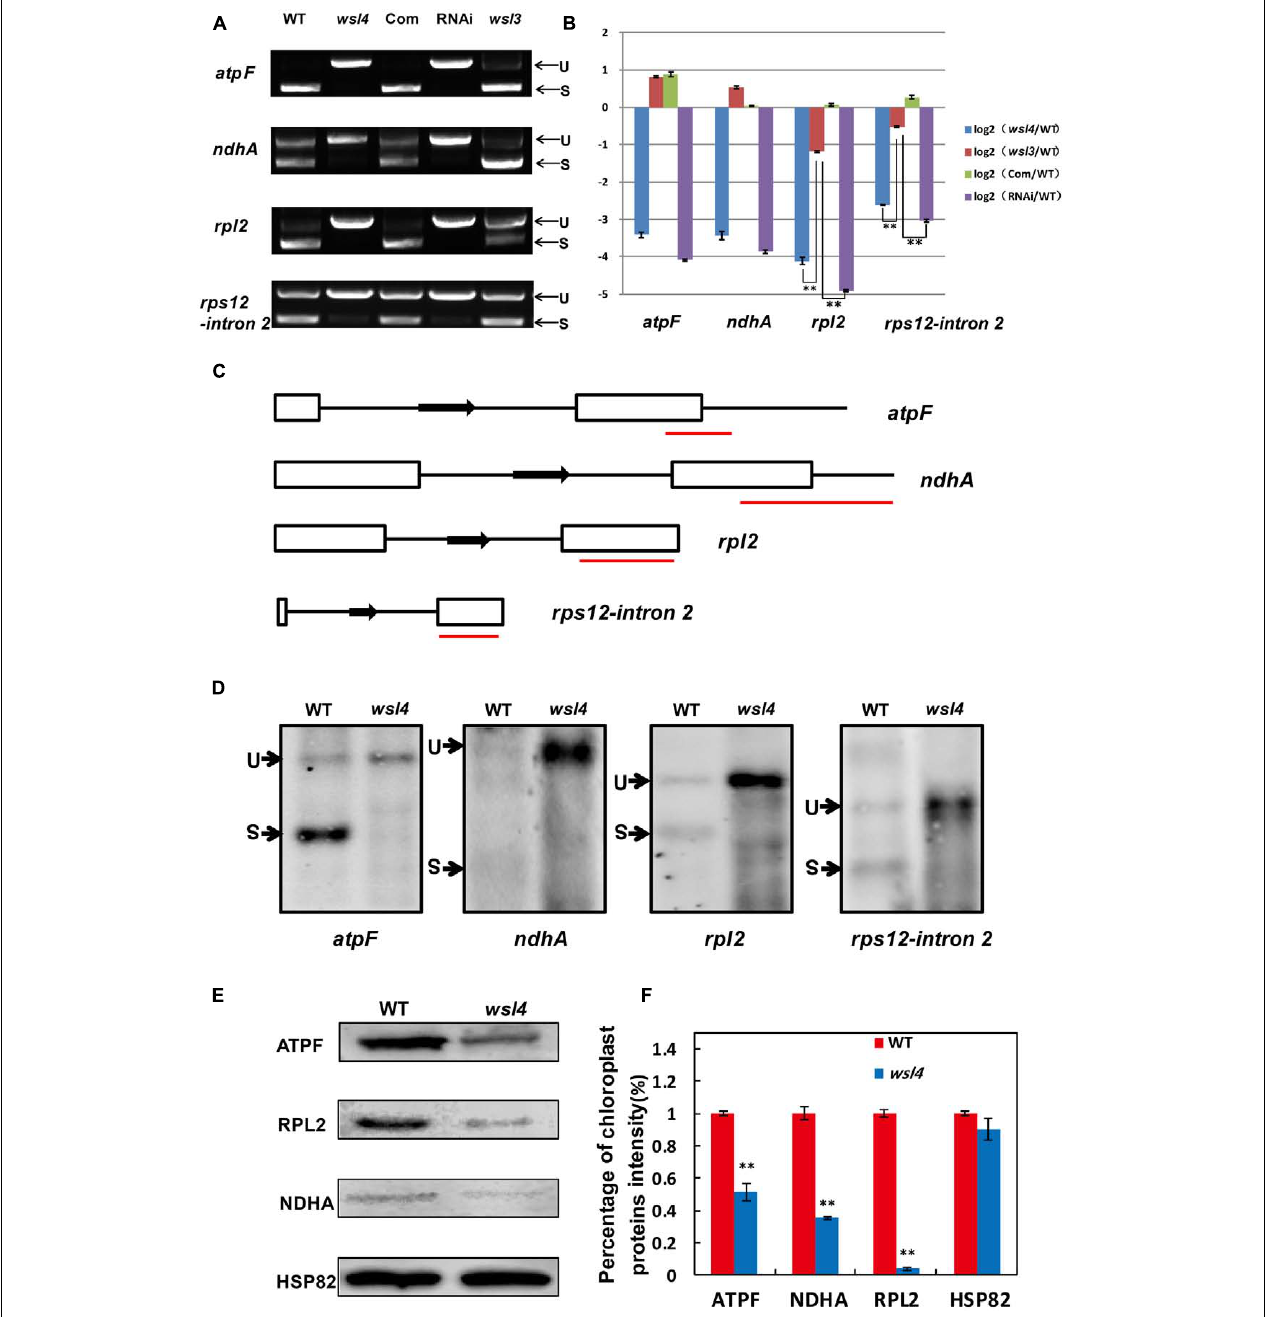
FIGURE 9 | Splicing analyses of four chloroplast group II introns in WT and wsl4 mutant. (A) RT-PCR analyses of atpF , ndhA , rpl2 , and rps12 transcripts in WT, wsl4 mutant (white striped sector), complemented (Com), RNAi (white striped sector), and a control wsl3 mutant with a transitory variegation phenotype. RT–PCR was performed with RNA extracted from L3-3 of the corresponding plants grown in a growth chamber at L30/D25. L3-3 indicates the third leaf at the three-leaf stage. (B) Quantitative RT-PCR analyses of atpF , ndhA , rpl2 , and rps12 transcripts in WT, wsl4 mutant (white striped sector), Com, RNAi (white striped sector), and the wsl3 mutant plants grown in a growth chamber at L30/D25. Histograms show log2 ratios of spliced to unspliced RNA in wsl4 , wsl3 , Com, and RNAi plants as compared with WT. Values are means ± SD of three replicates. (C) Sketch map of the atpF , ndhA , rpl2 , and rps12 transcripts. The red lines represent the probes used in (D) . (D) RNA gel blot assays of atpF , ndhA , rpl2 , and rps12 splicing in WT and wsl4 mutant. Positions of spliced (S) and unspliced (U) transcripts are shown at the left. RNA was extracted from L3-3 of WT and wsl4 mutant plants grown in a growth chamber at L30/D25. L3-3 indicates the third leaf at the three-leaf stage. (E) Immunoblot analyses of ATPF, NDHA, and RPL2 in WT and wsl4 mutant at the three-leaf stage. Total proteins were extracted from L3-3 of WT and wsl4 mutant plants grown in a growth chamber at L30/D25. L3-3 indicates the third leaf at the three-leaf stage. HSP82 was used as an internal control. (F) Quantification of the band intensity of ATPF, NDHA, and RPL2 in wsl4 mutant compared to WT corresponding to (E) . Data are means ± SD of three repeats. Student’s t -test: ∗ P < 0.05; ∗∗ P < 0.01.